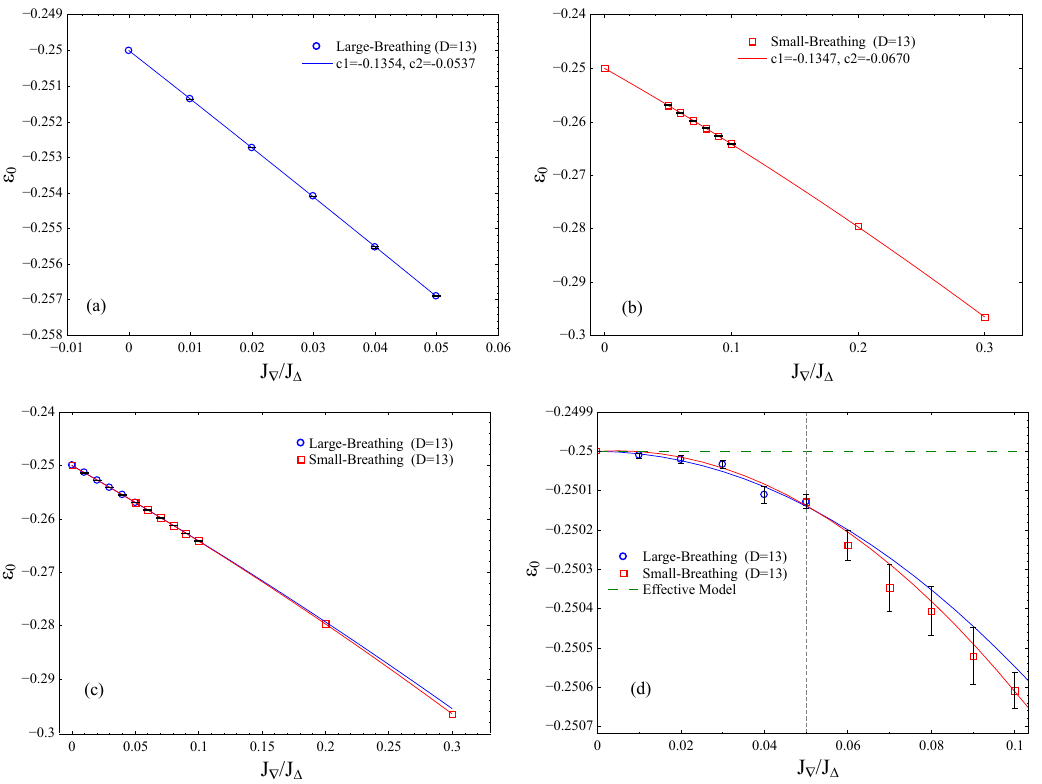
Figure 9: (Color online) Fitting the PESS energies ( D = 13) in the (a) nematic and (b) U(1) QSL phases using the c and c coefficients of Table 2. (c) Level cross- 1 2 ing of the the small- and large-breathing series. (d) In order to observe the level crossing and the first-order nature of the QPT more appropriately, we have sub- tracted the linear correction of the effective model from all data points and fits, i.e., (cid:34) − 0.1353 ( J / J ) . The error bars are standard deviation from the mean-value of (cid:53) (cid:52) 0 PESS data for different